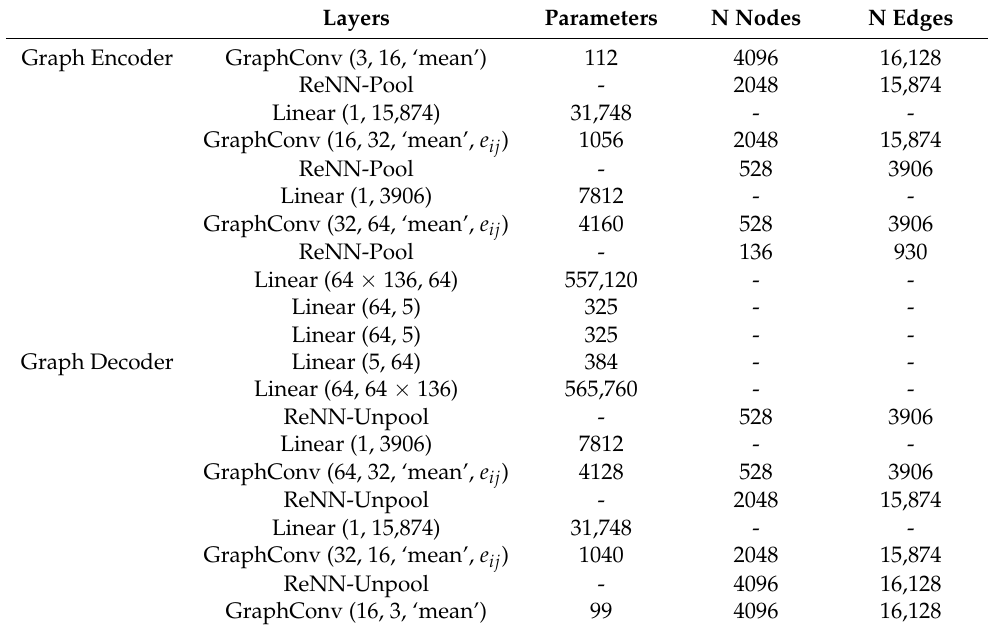
Table A2. ReNN Graph VAE for sprite dataset.